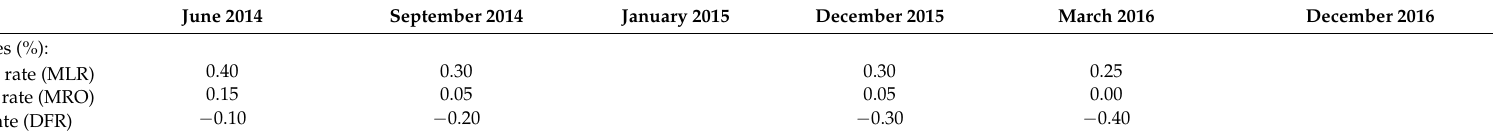
Table 1. Timeline of main ECB monetary policy decisions from June 2014 to December